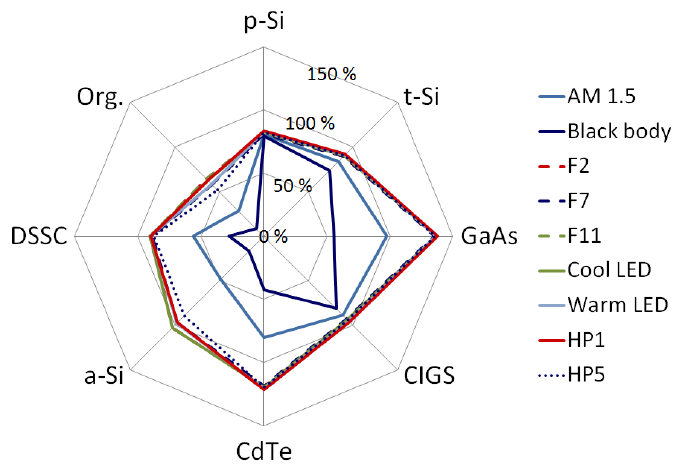
Figure 6. The calculated relative output of the different photovoltaic solar cells under different lighting conditions, compared to the crystalline silicon solar cell as